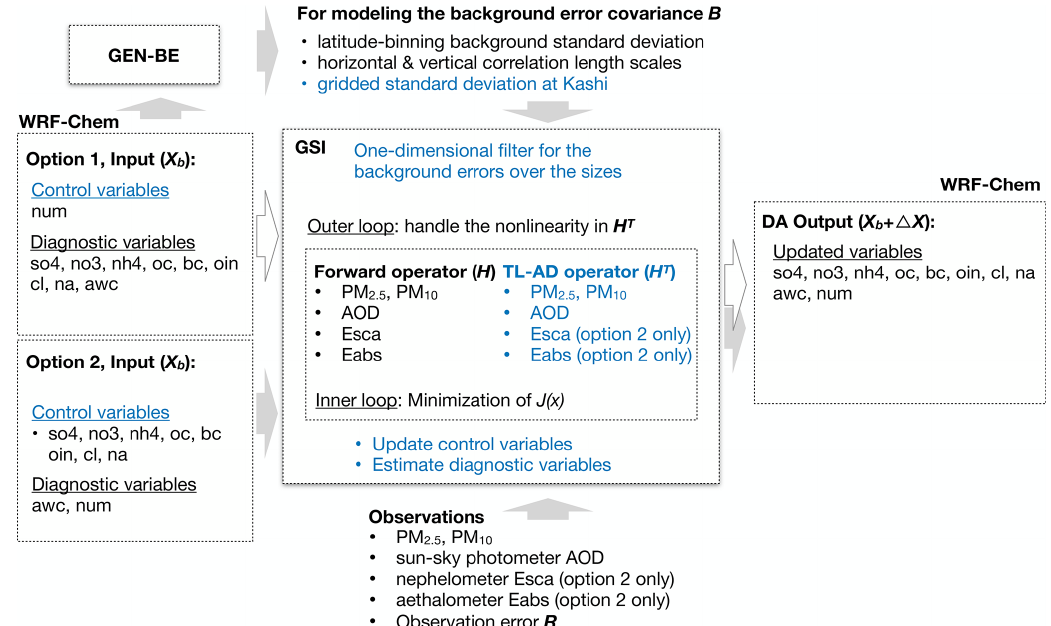
Figure 1. The workflow of aerosol DA in the revised GSI system for the sectional MOSAIC aerosols in WRF-Chem. The contents in blue are the portions we developed. The arrows in gray indicate the workflow of option 2, which was performed in this study to assimilate the aerosol scattering or absorption coefficients. Abbreviations: so4, sulfate; nh4, ammonium; oc, organic carbon; bc, black carbon; oin, other inorganic matter; awc, aerosol water content; num, aerosol number concentration; no3, nitrate; cl, chlorine; na, sodium; Esca, aerosol scattering coefficient; Eabs, aerosol absorption